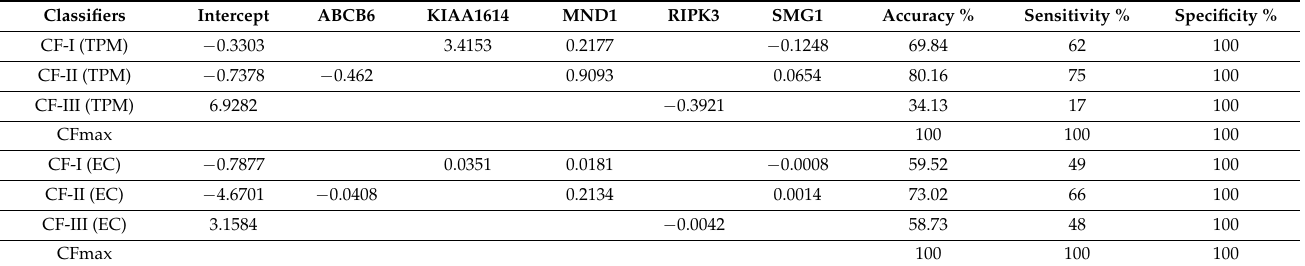
Table 1. Performance of individual classifiers and combined max-competing classifiers in Equations (5) and (6).